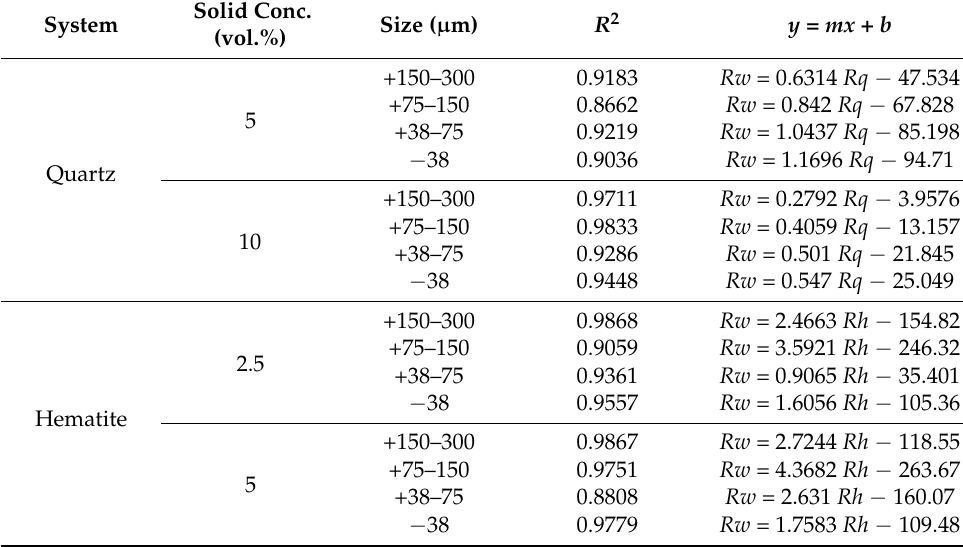
Table 3. Summary of linear correlation between water recovery and particle recovery. Rw , Rq , and Rh are the respective recoveries of water, quartz, and